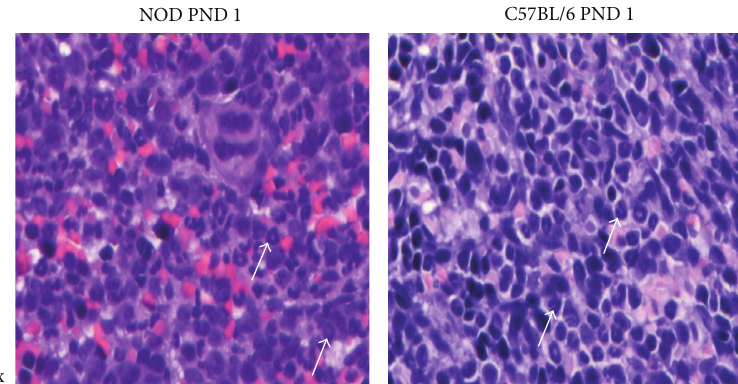
Figure 5: Hematoxylin and eosin (HE) staining of neonatal spleen PND 1 from NOD mice and C57BL/6. Arrows depict granulocytes at different stage of granulopoiesis. 60x magnification.